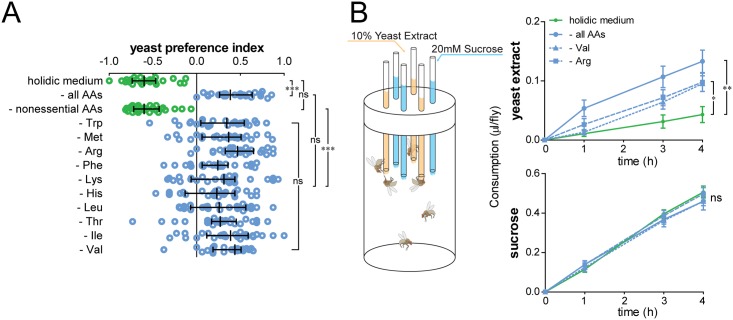
Flies specifically increase yeast appetite upon single essential amino acid (eAA) deprivation.(A) Feeding preference of flies kept on holidic medium or holidic medium lacking all amino acids (AAs), all nonessential amino acids (neAAs), or single eAAs in the context of no neAAs. Circles represent yeast preference in single assays, with a line representing the median and whiskers representing the interquartile range. n = 26. Significance was tested using the Kruskal–Wallis test followed by Dunn’s multiple comparison test. (B) Cumulative intake measurement of yeast extract and sucrose using the capillary feeder (CAFE) assay. Flies were prefed a holidic diet containing either all AAs, no AAs, all AAs except valine (Val), or all AAs except arginine (Arg). Dots represent means and error bars represent the standard error of the mean. n = 10. Significance was tested using the unpaired t test with Bonferroni correction for the intake volume at 4 h. For yeast extract intake in (B), Val and Arg deprivation have the same effect when compared to the complete holidic medium. There was also no significant effect of the different diets on sucrose intake. Not significant (ns) p > 0.05, * p < 0.05, ** p < 0.01, *** p < 0.001. Underlying data used in this Fig are provided in S1 Data.